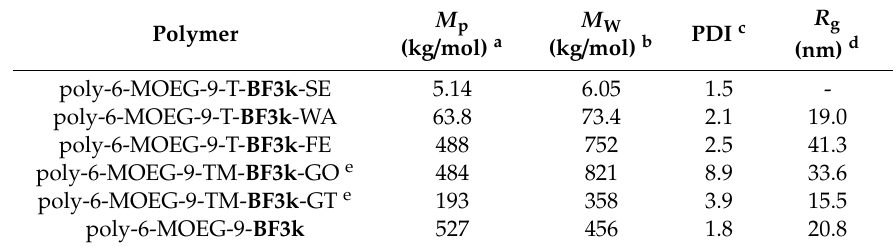
Macromolecular features of the newly-synthesized poly-6-MOEG-9-T- BF3k samples in comparison with the ones shown by previously described poly-6-MOEG-9-TM- BF3k , and poly-6-MOEG-9- BF3k